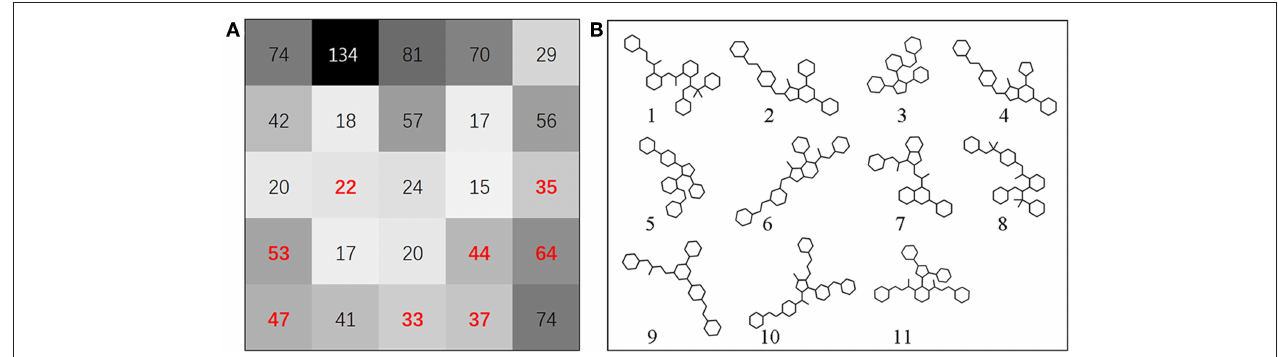
FIGURE 4 | (A) SOM projection of positive set and screened compounds. Black shading indicates compound density. Compounds were represented by CATS descriptors. The number in the grid represents the number of compounds. The position of red number in grid represents the source of the hit compounds we finally selected. In this research, the SOM technique can be used to identify preferred hit compounds. (B) The scaffold structure of selected molecules. Scaffold 1, 3, and 5 are located in cluster (1/4), scaffold 2 is located in cluster (1/1), scaffold 4, 6 are located in cluster (2/1), scaffold 7 is located in cluster (2/5), scaffold 8 is located in cluster (1/3), scaffold 9 is located in cluster (3/5), scaffold 10 is located in cluster (3/2), scaffold 11 is located in cluster